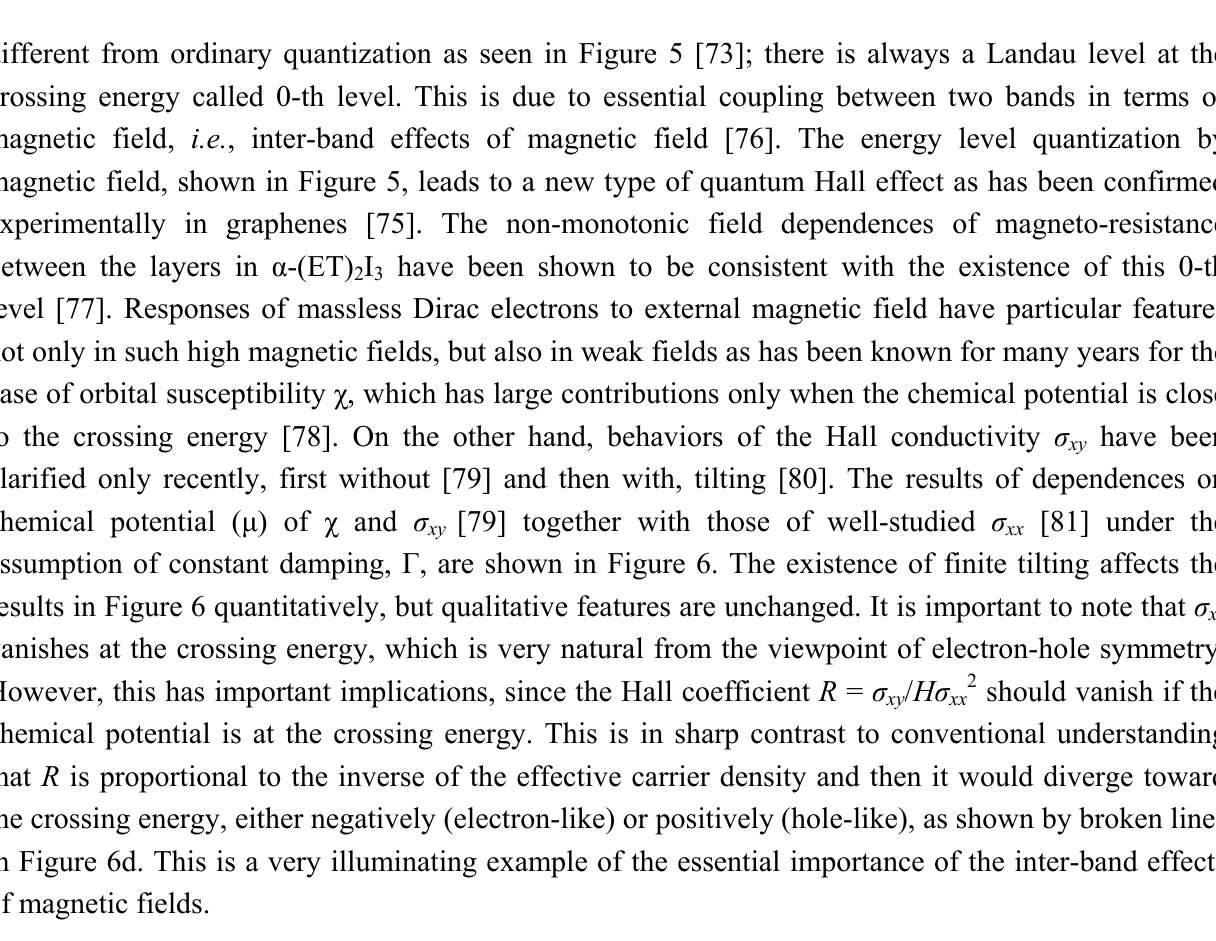
Figure 5. Magnetic field dependences of energy levels of two-dimensional massless Dirac electrons with perpendicular